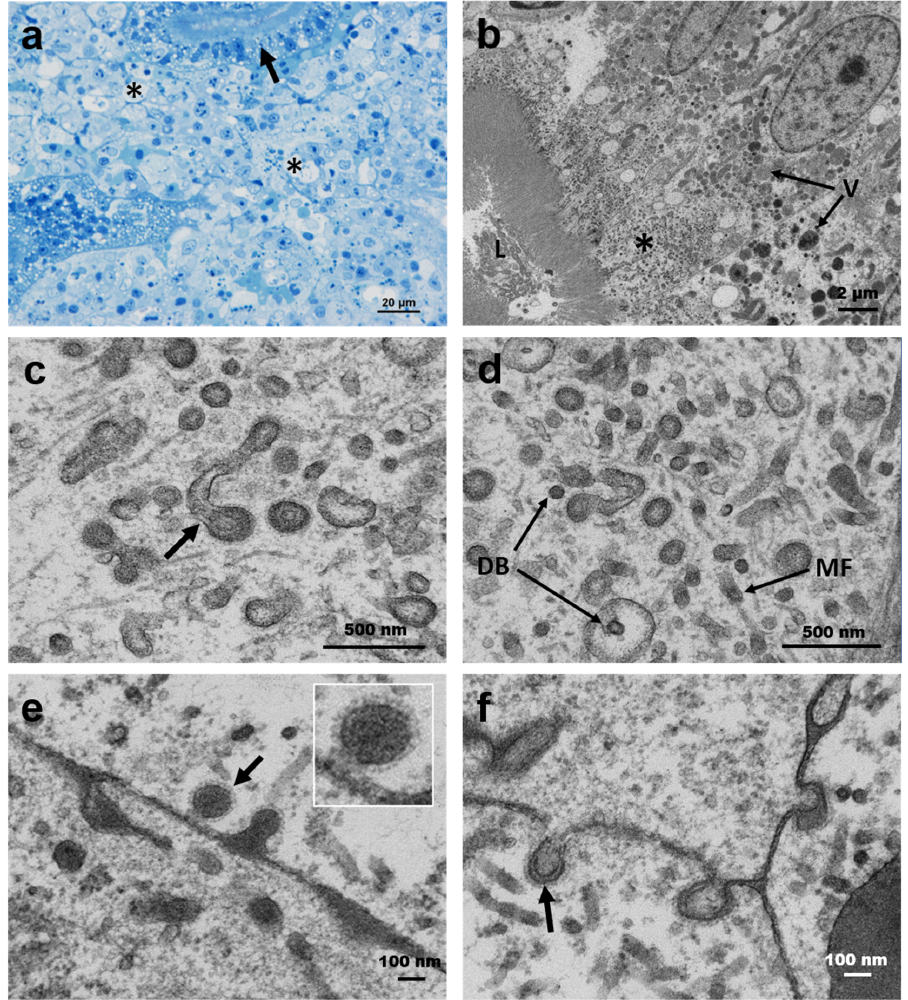
Figure 6. ( a ) Semithin section of the kidney of moribund goldfish showing cellular necrosis in interstitial cells (asterisks) and renal tubule epithelium (arrow). ( b – f ) Virogenesis in the proximal renal tubule epithelium. ( b ) Semithin resin section showing the apical region of the infected cell bordering the renal tubule lumen (L) and infected epithelial cell with numerous large vacuoles (V) containing granular and more electron-dense material that was mostly located between the nucleus and the viral assembly area (asterisk) in the apical portion of the cell. ( c ) Virions budding from tubular structures comprising the endoplasmic reticulum with the insertion of external microtubular material (arrow). ( d ) Internally fuzzy-coated vesicles with internal dense bodies (DB) and similar structures in the cytosol. The tubular structures are seen in ( a , b ); microfilaments (MF) and viral budding are also visible. ( e , f ) Viral budding from renal interstitial cell membranes. The top inserts show the detail of mature virions with spikes on the surface.